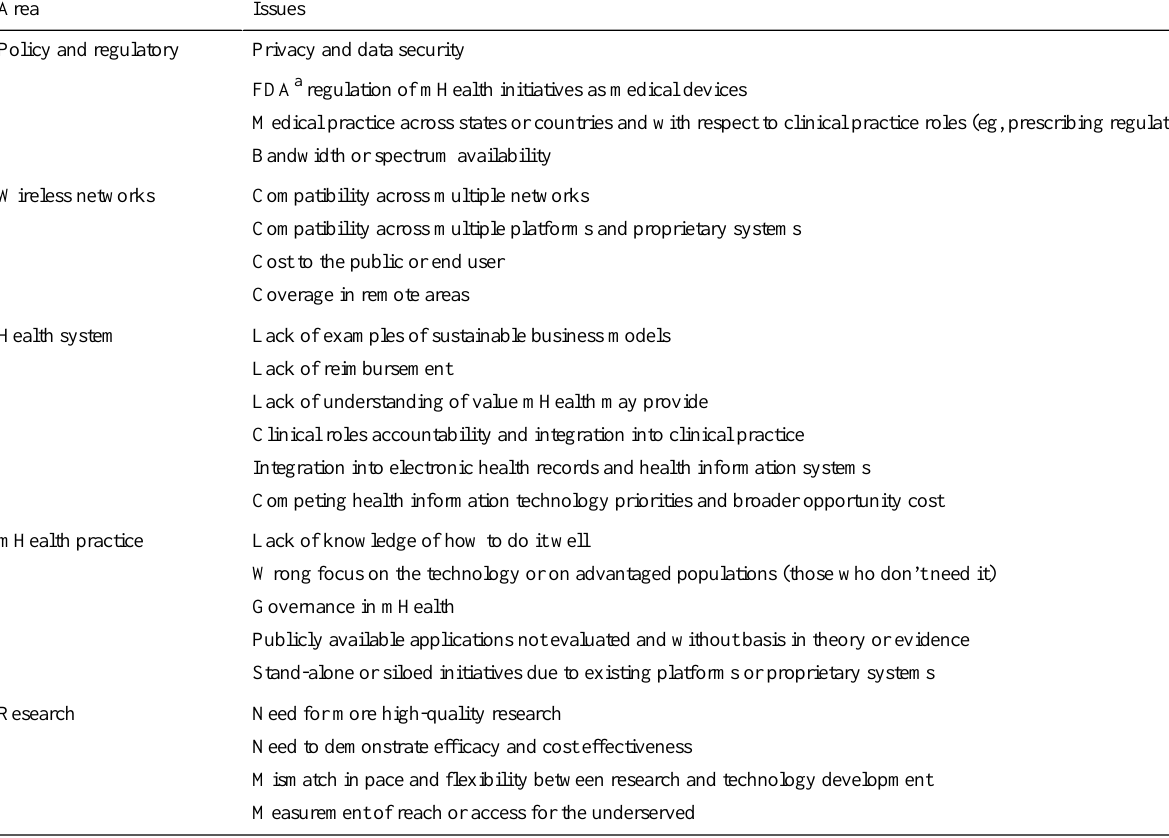
Table 1. Issues facing the implementation of mHealth raised by key